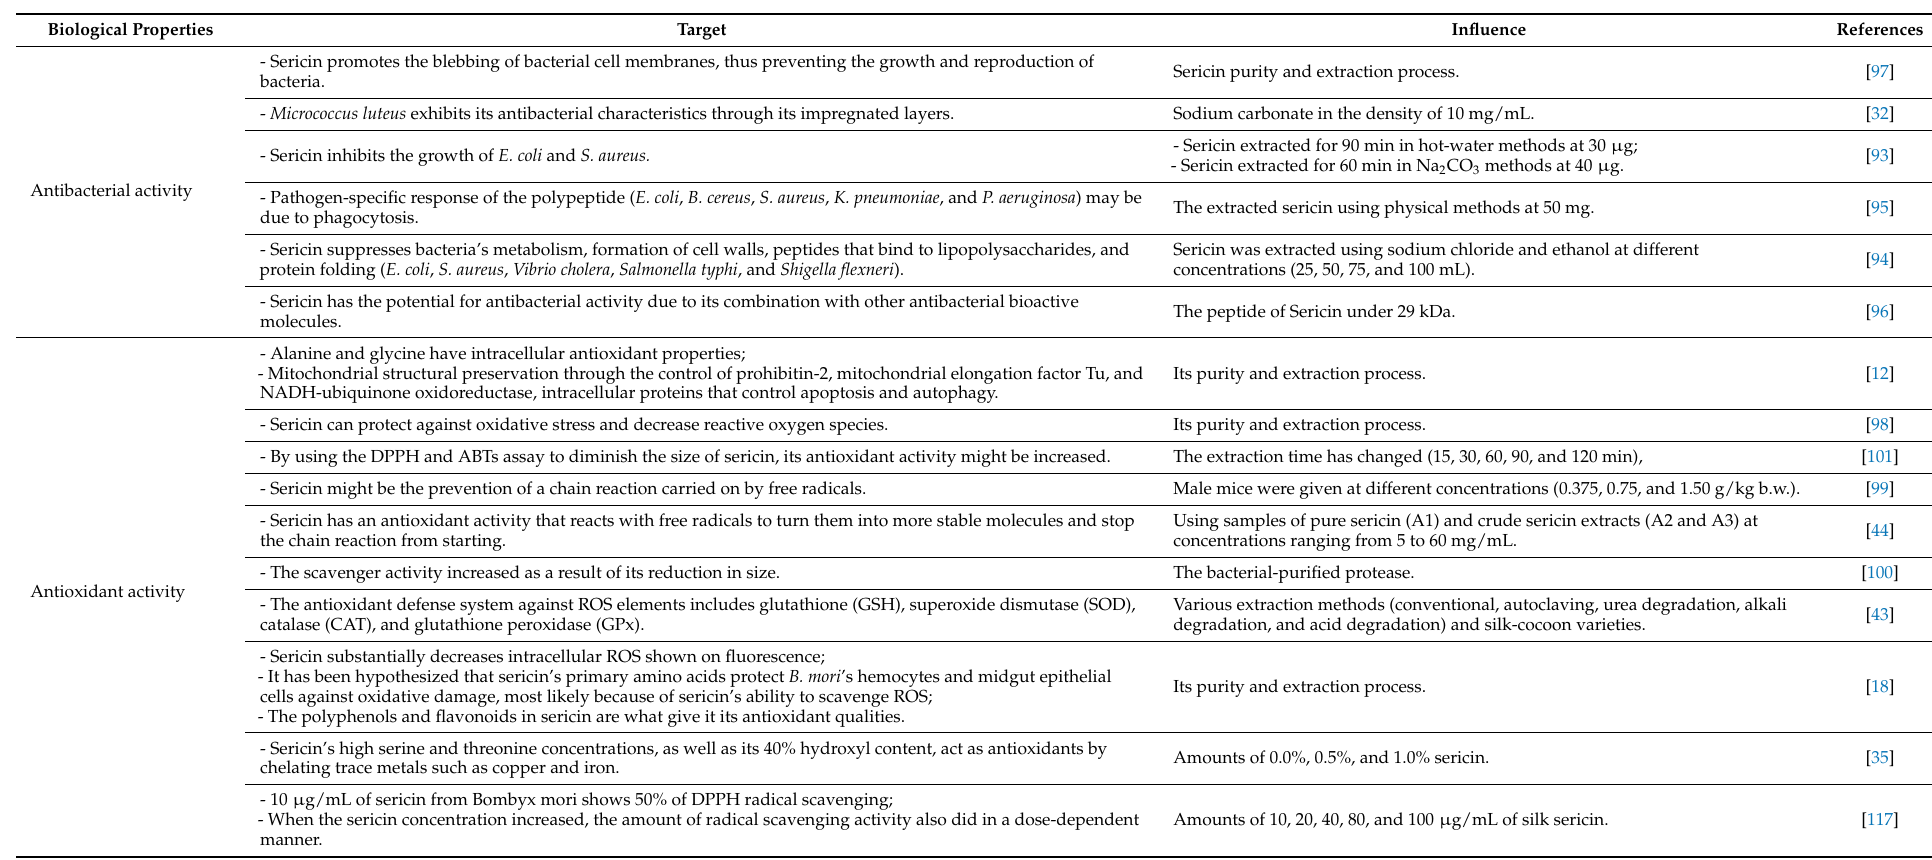
Table 6. Biological properties of